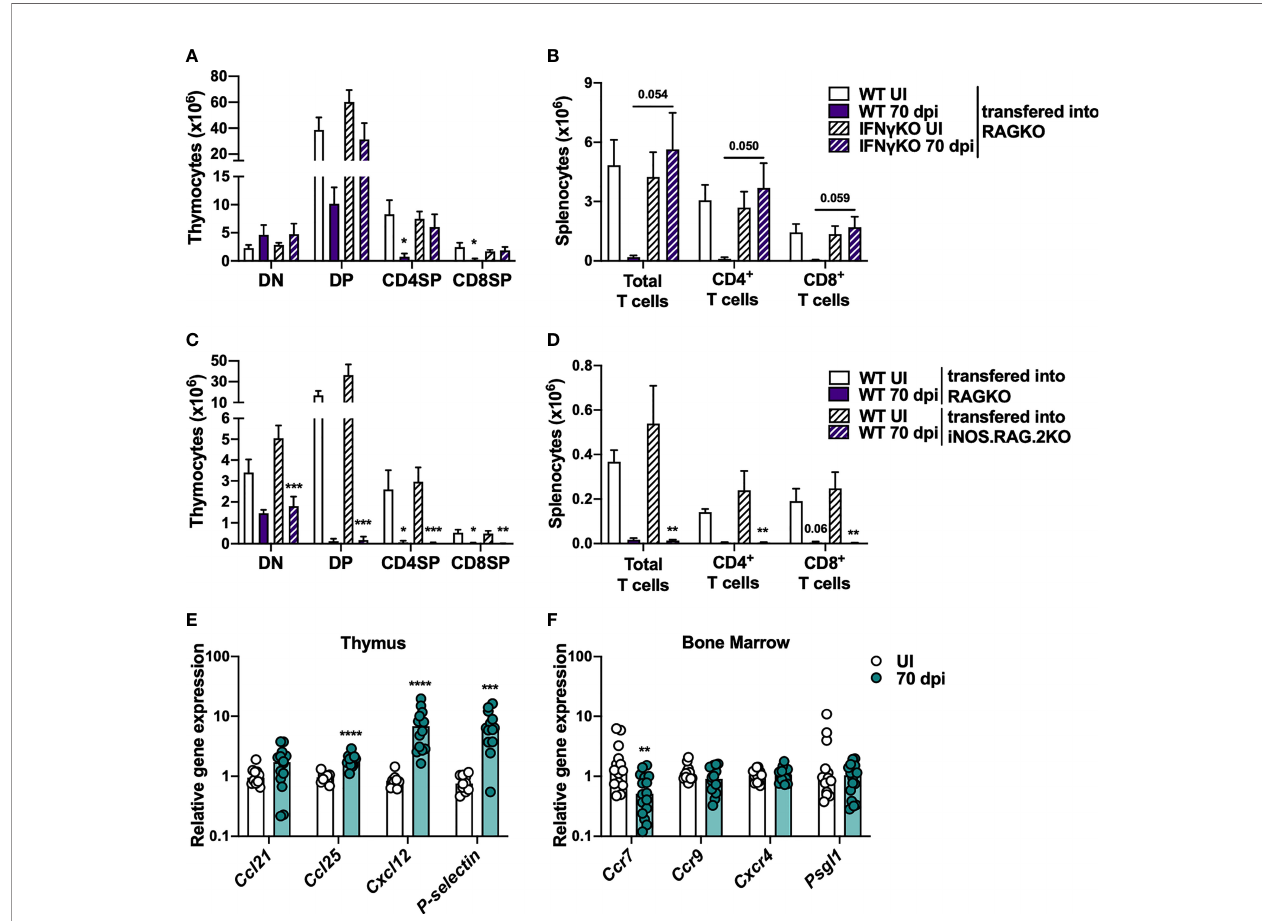
FIGURE 4 | Overall decreased ability to reconstitute thymi from RAGKO mice by BM cells from M. avium strain 25291 infected mice is IFN g -dependent. (A, B) RAGKO mice were reconstituted with lineage negative BM cells from uninfected (white) or 70 days M. avium 25291 infected (purple) WT (solid) or IFN g KO mice (dashed). (A) Number of the four main thymocyte populations (DN, DP, CD4SP and CD8SP). (B) Number of splenic total T cells, and of CD4 + and CD8 + T cells. (C, D) RAGKO (solid) or iNOS.RAG.2KO (dashed) mice were reconstituted with lineage negative BM cells from uninfected (white) or 70 days M. avium 25291 infected (purple) WT mice. (C) Number of cells from the four main thymocyte populations. (D) Number of splenic T cells and its subpopulations. RNA expression levels in WT mice uninfected (white) or infected with M. avium strain 25291 for 70 days (teal). (E) Expression in the thymus of the chemokines Ccl21 , Ccl25 and Cxcl12 , and of P-selectin . (F) Expression in the BM of the chemokines receptors Ccr7 , Ccr9 and Cxcr4 , and of Psgl1 . In (A – D) bars represent the mean + SEM from 3 to 6 mice per group from one of two independent experiments. Comparisons were performed using 2-way ANOVA followed by Tukey ’ s multiple comparisons test, and marked between infected and uninfected mice as: * p < 0.05, **p < 0.01, *** p < 0.001. For p -values between [0.05; 0.10], their values are represented in the graphs. In E and F bars represent the median from 10 to 16 mice per group from two pooled independent experiments. Comparisons between infected and uninfected were performed by two-tailed unpaired t -test or Mann-Whitney test, according to normality, and marked as **p < 0.01, *** p < 0.001, **** p < 0.0001. UI stands for uninfected. dpi stands for days post infection. DN stands for double negative. DP stands for double positive. SP stands for single